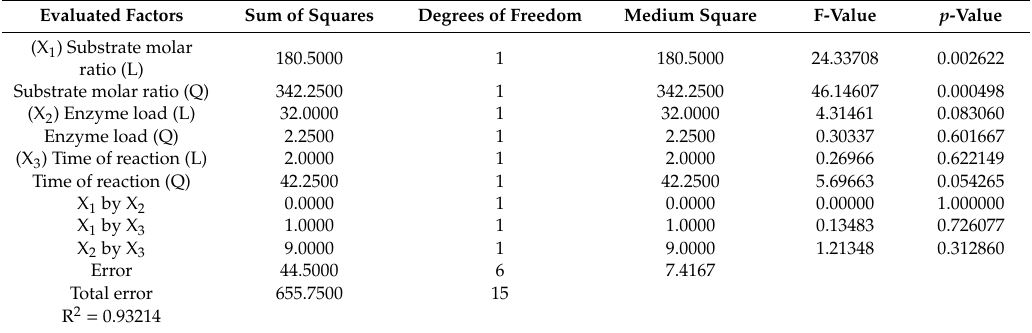
Table 2. Analysis of variance (ANOVA) for interesterification variables pertaining to the response of percent incorporation of 3,4DMCA to PC /